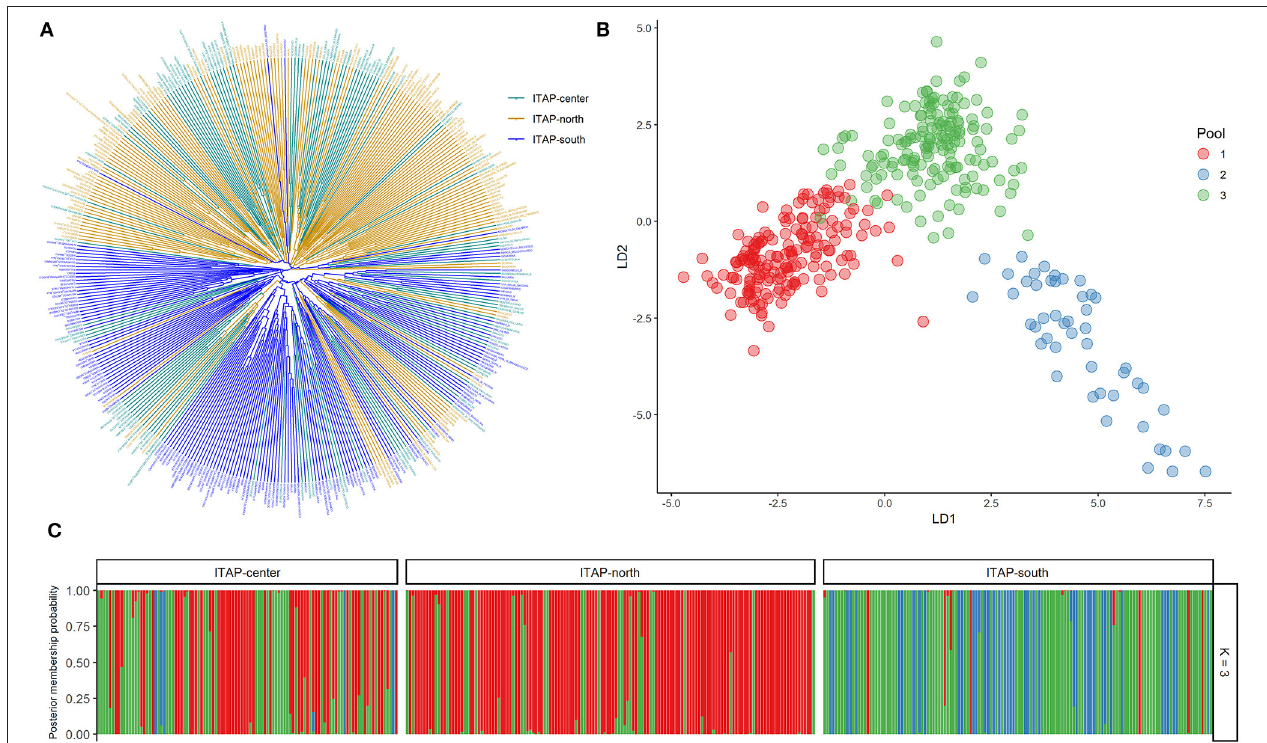
FIGURE 1 | Genetic diversity and population structure on 384 Italian grapevine genotypes analyzed by 18k SNP array. (A) UPGMA dendrogram. The varieties were highlighted based on their geographical origin. (B) DAPC scatter plot based on the first and second (LD) at the best K (3). (C) Bar plot of the posterior probability for the best K (3) of group assignment for each sample belonging to different origins. UPGMA, unweighted pair group method with arithmetic mean; DAPC, discriminant analysis of principal